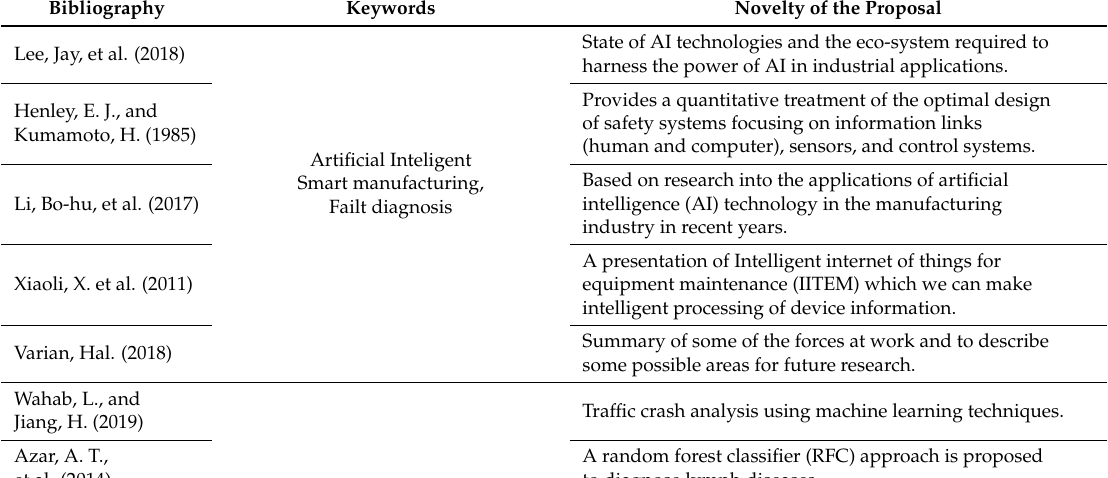
Table 4. Proposals related to Smart manufacturing and Machine